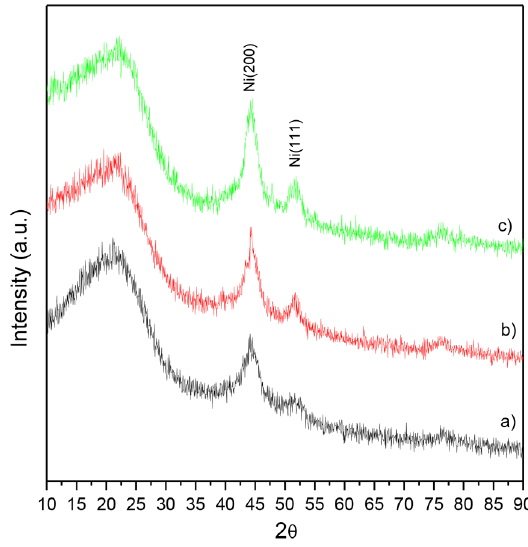
Figure 2. XRD of (a) Ni-C500; (b) Ni-C600 and (c) Ni-C700